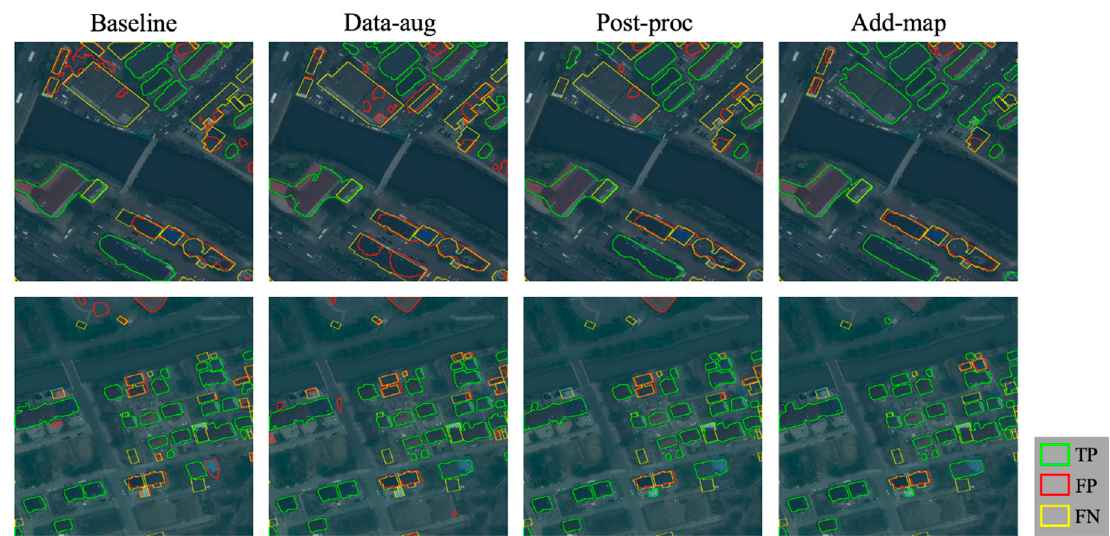
Figure 7. Examples of building extraction results for Paris using different strategies.